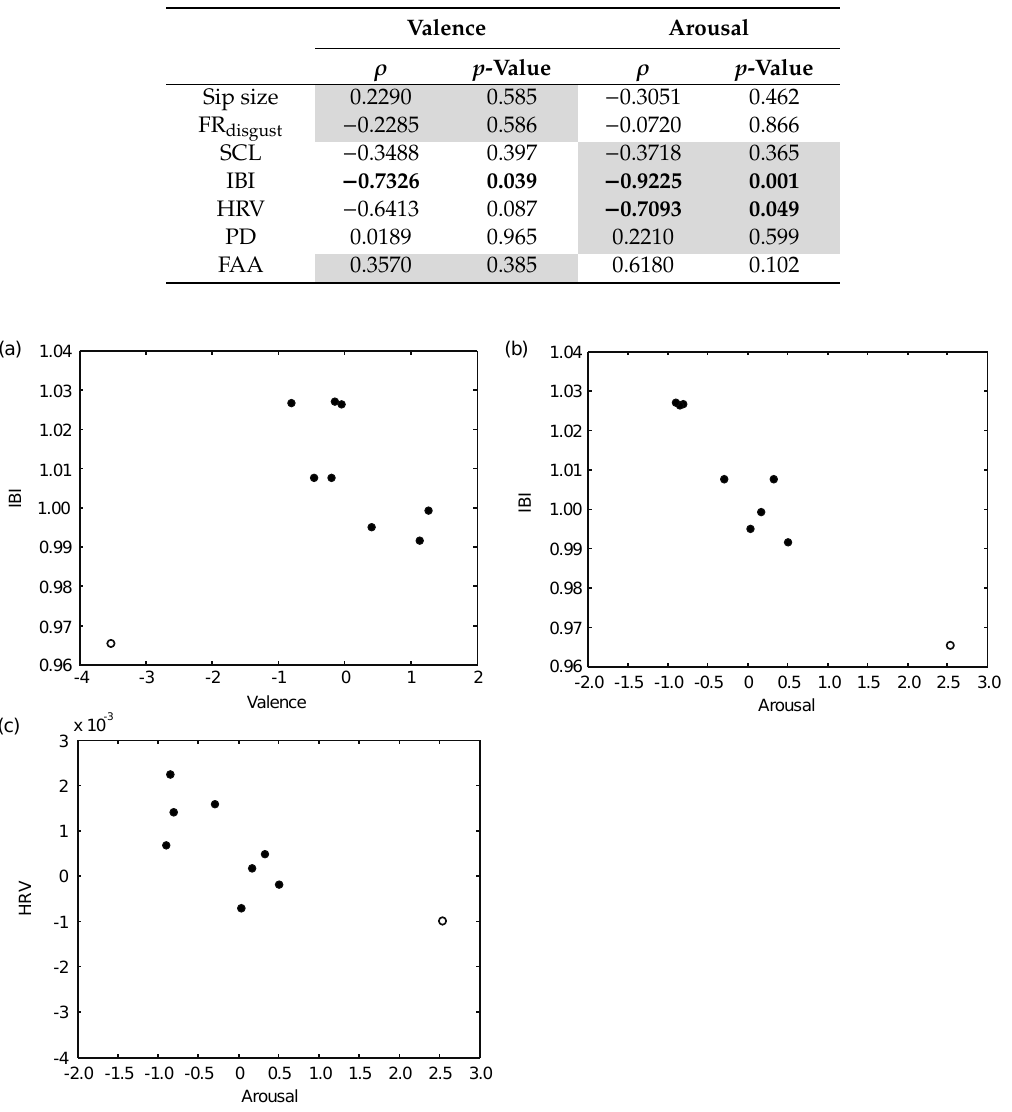
Figure 5. The data plots displaying the significant correlations between ( a ) valence and IBI, ( b ) arousal and IBI, and ( c ) arousal and HRV. Solid circles represent the eight regular drinks, and the open circle represents the vinegar solution. Note that correlation analysis were performed on the eight regular drinks